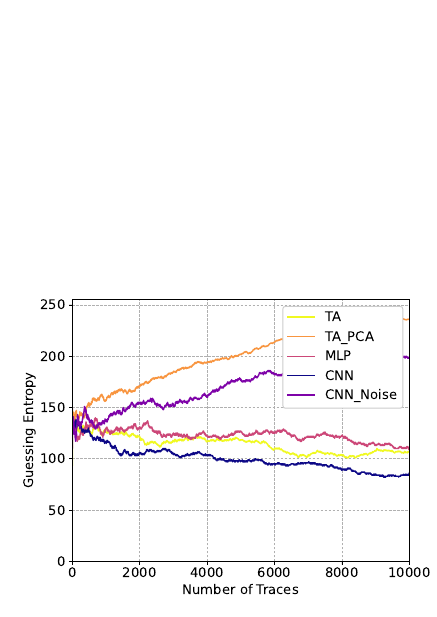
Figure 19: All in one (random key): guessing